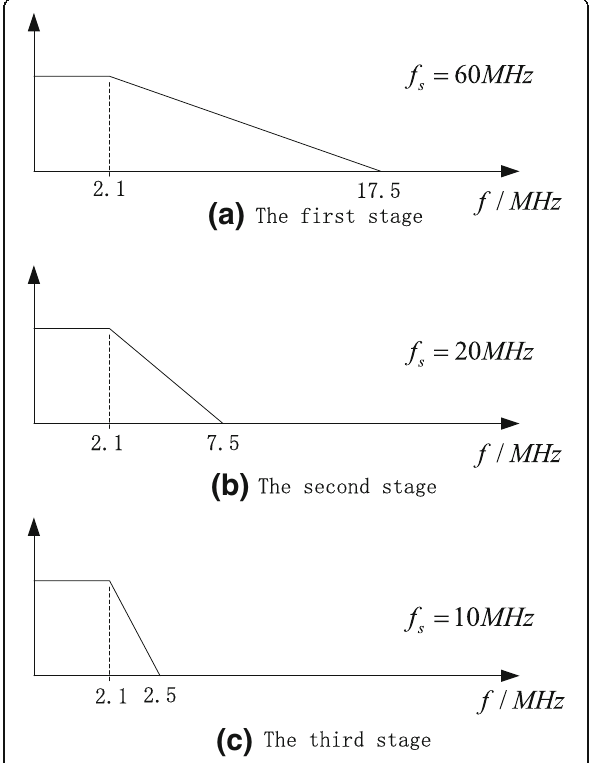
Fig. 9 Each stage of the Hamming window filter design for